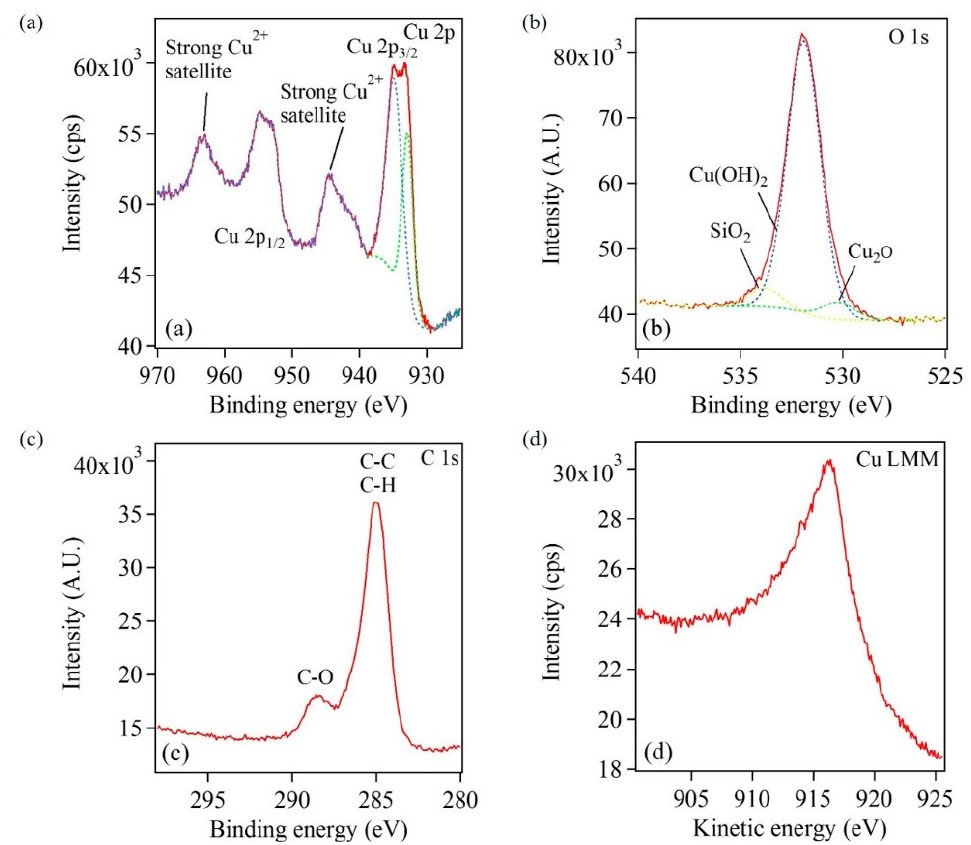
Figure 11. XPS spectra showing ( a ) Cu 2p peaks corresponding to different oxidation states of Cu, ( b ) O 1s peaks corresponding to different oxide species, and ( c ) C 1s peaks corresponding to various carbon bonds ( d ) AES spectrum showing Cu LMM peak that resemble Cu(OH) 2 and Cu 2 O. The dashed curves in ( a ) and ( b ) represent Gaussian curve fits.